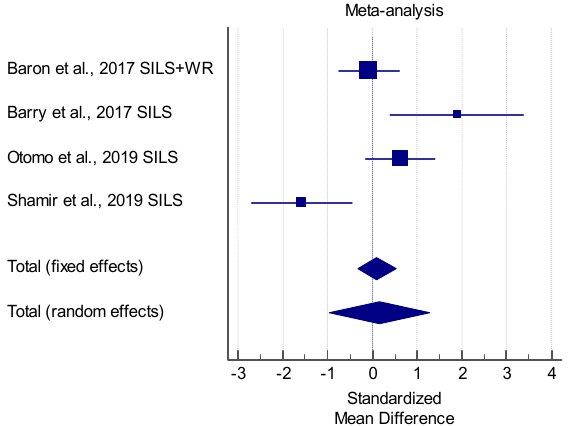
Figure 4. Forest-plot chart of the articles analyzed in terms of the surgical time of Gastrointestinal (GI) procedures. (Q 18.4577; I 2 83.75 %; p = 0.0004).